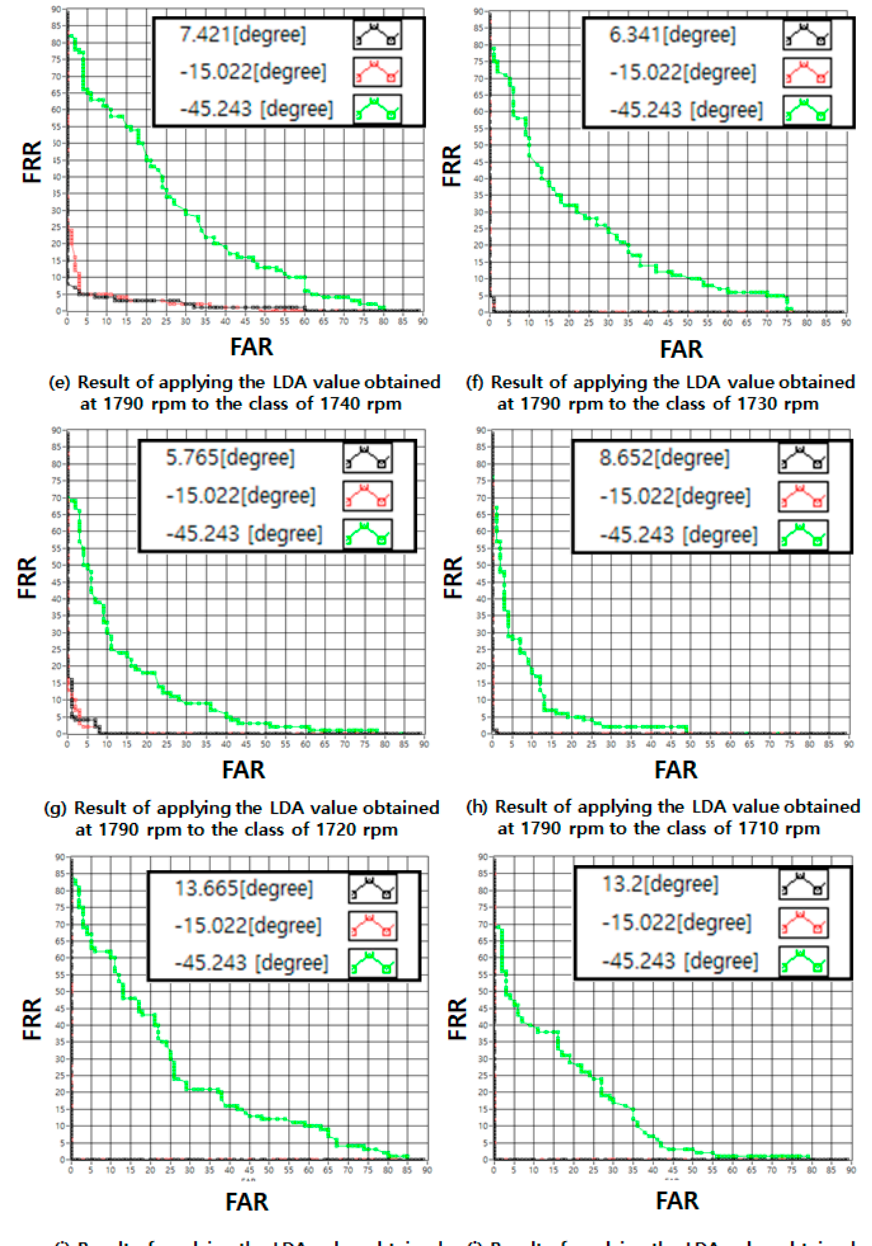
Figure 19. FAR–FRR interaction graph when minimum light load LDA degree was applied to each speed.